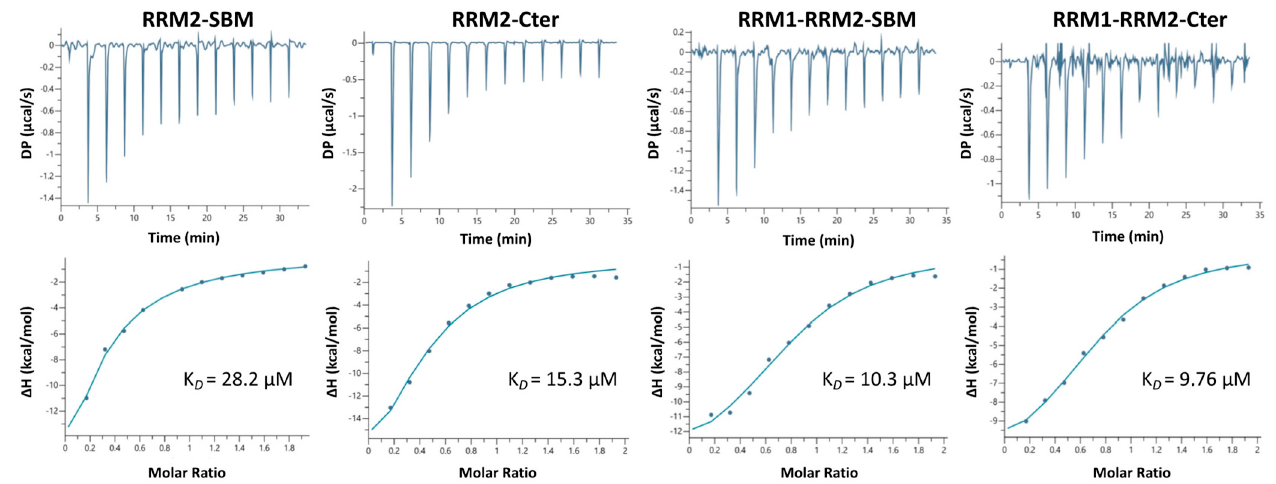
Figure 7. ITC analysis of the interactions between the human La polypeptides (RRM2-SBM, RRM2- Cter, RRM1-RRM2-SBM and RRM1-RRM2-Cter) and IRES-HCV domain IV. The upper graph in each plot displays the raw data, and the lower graph displays the intergraded heat per injection (circles) and the best fit function (solid line). K D values are presented for each